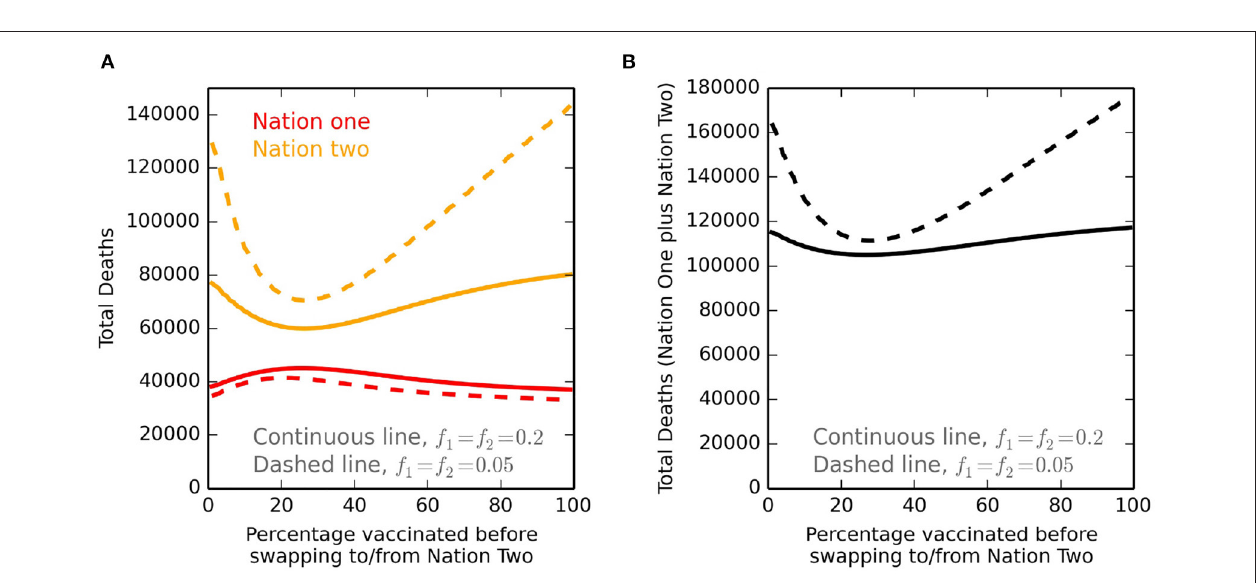
FIGURE 2 | Deaths for different X values defining vaccine sharing. (A) Total deaths for nation one (red) and nation two (orange), at the time of full vaccination of both nations. The vaccine sharing policy is the same as that presented in Figure 1 , except that here the percentage of nation one vaccinated before sharing, X , is tested across all percentage values. Hence, for extensive travel exchange with f 1 = f 2 = 0.2 and with X = 20 % , the values shown are identical to the annotated total deaths in the second row of Figure 1 . The continuous lines are for f 1 = f 2 = 0.2, and the dashed lines are for less travel exchange with f 1 = f 2 = 0.05. All other parameters are as given in Table 1 . (B) Shows the total deaths, and so is the addition of the nation one and nation two deaths of (A)